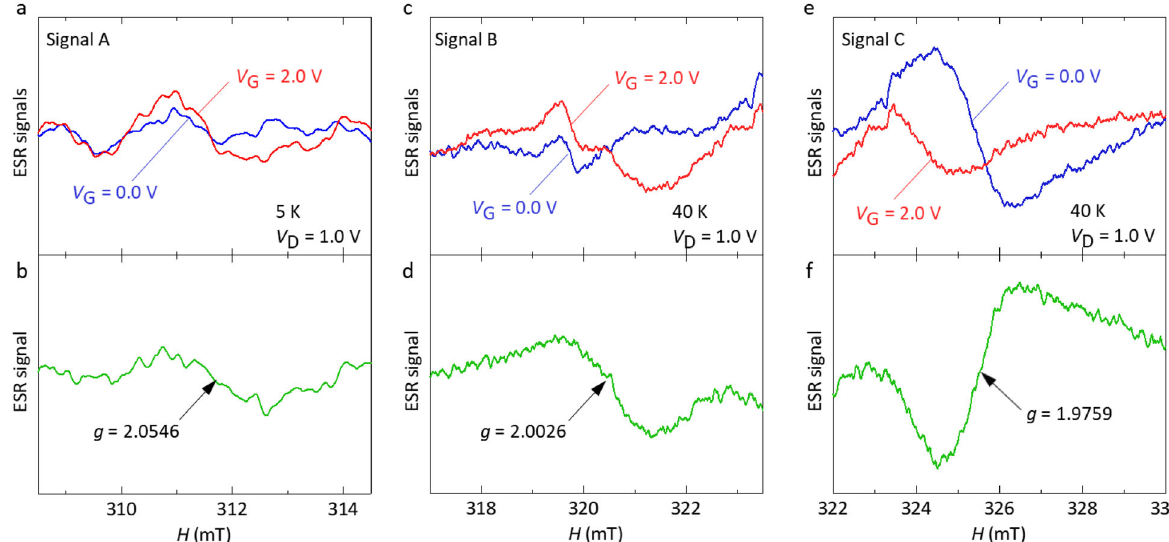
Fig. 3 Gate-voltage dependence of ESR spectra (upper data) and their difference spectra (lower data). The red lines show the spectra at V G = 2 V and V D = 1 V. The blue lines show the spectra at V G = 0 V and V D = 1 V. The data at V G = 2 and 0 V contain the background signal and baseline ’ s distortion due to the ESR cavity resonator. The green lines show the difference spectra obtained by subtracting the ESR spectra at V G = 0 V from that at V G = 2 V. These data almost do not contain the background signal and baseline ’ s distortion due to the ESR cavity resonator. a Enlarged view of the ESR spectra of Signal A at 5 K shown in Fig. 2. Baseline correction has been performed on the background signal from the ESR cavity resonator. b Difference ESR spectrum of Signal A shown in a . c , e Enlarged views of the ESR spectra of the Signals B and C shown in Fig. 2, respectively. d , f Difference ESR spectrum of the Signals B and C shown in c , e ,